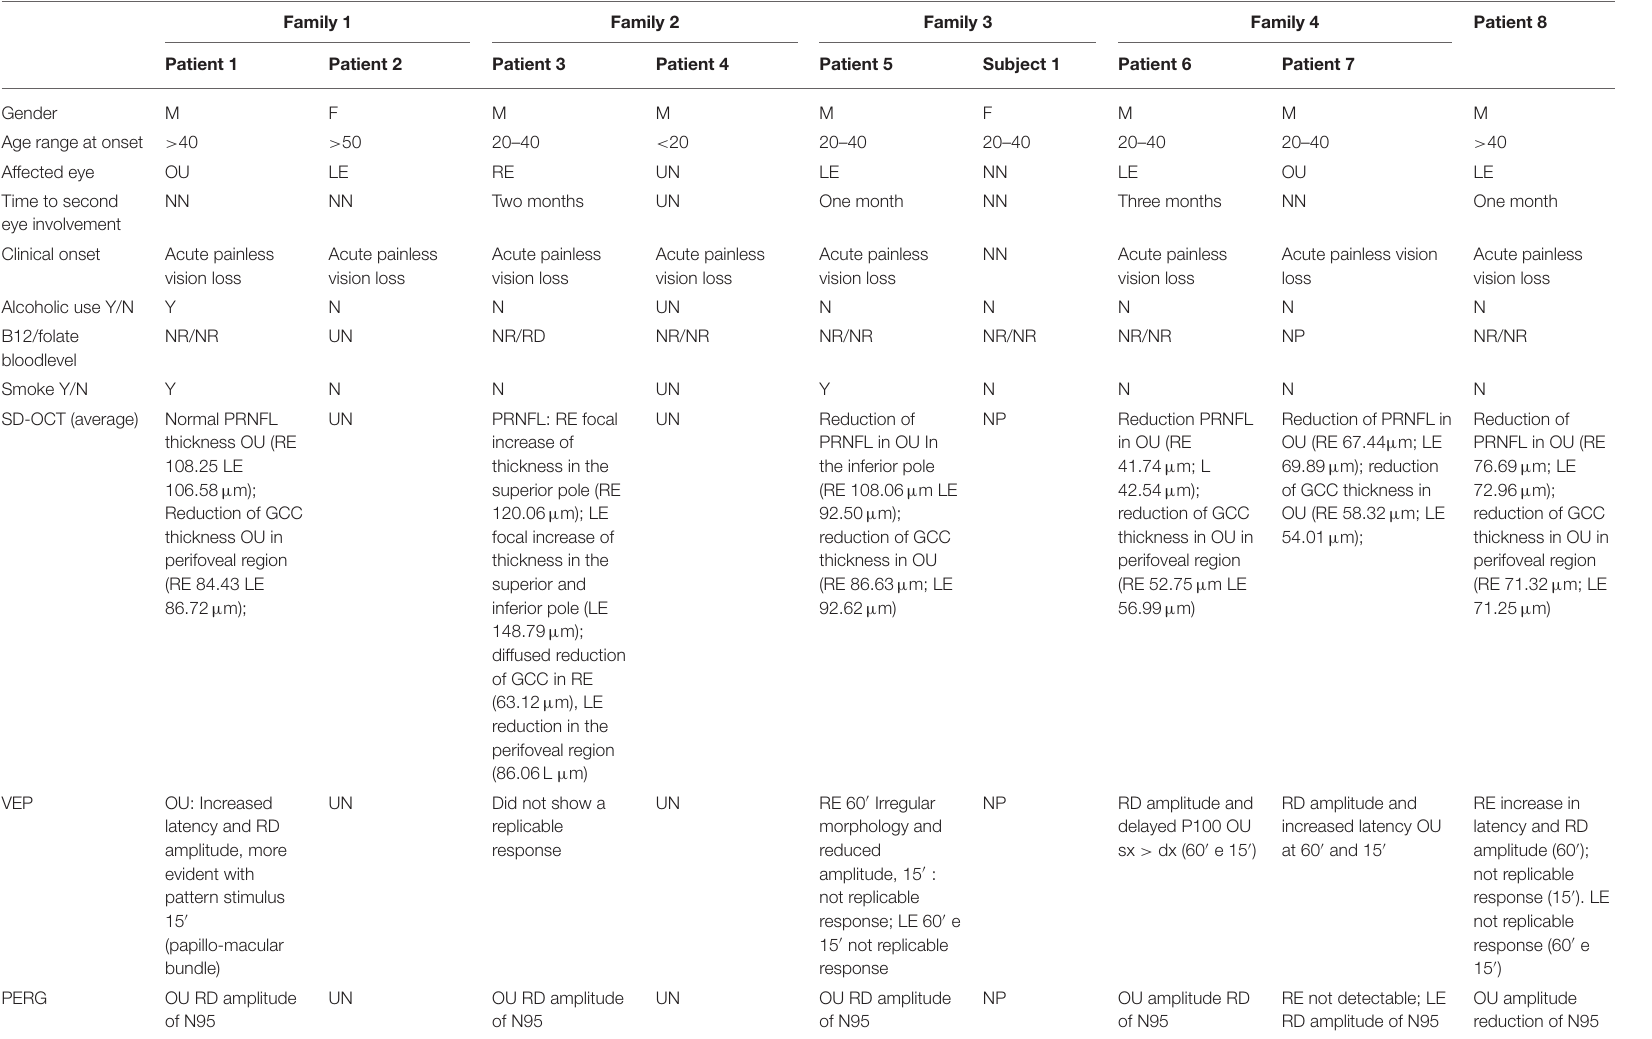
TABLE 1 | Schematic summary of patients’clinical, instrumental, and molecular examinations (see also Supplementary Material 1